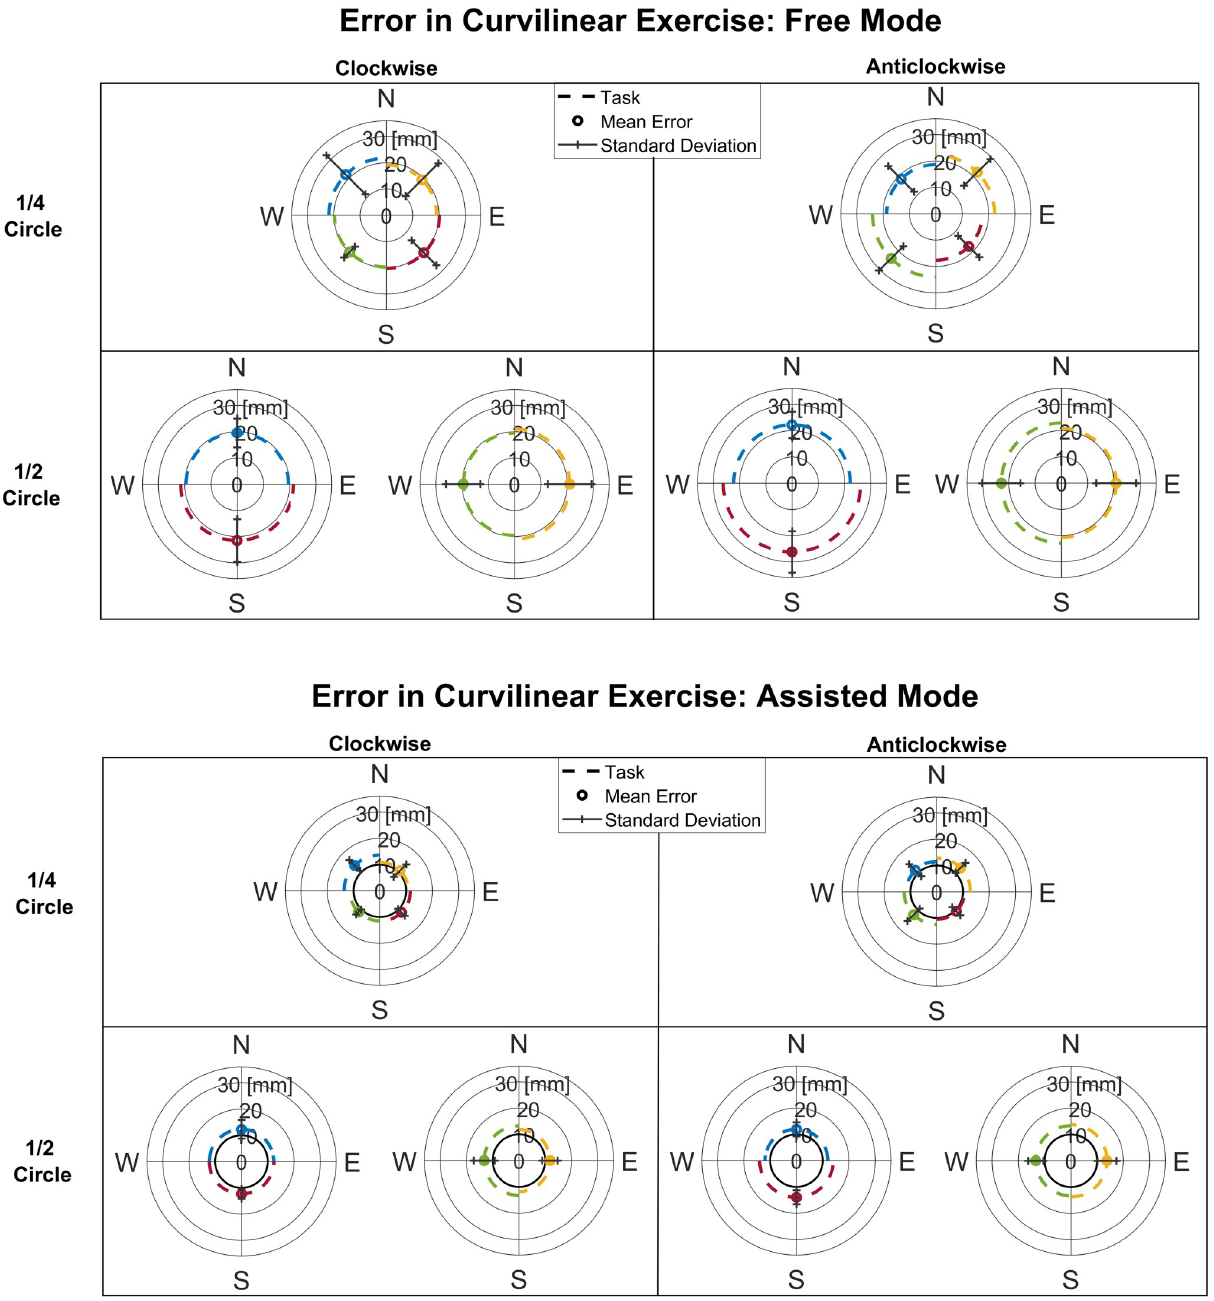
Fig 7. Curvilinear kinematic error. Mean inter-subject error and deviation in the curvilinear tasks in Free mode (upper panel) and in Assisted mode (lower panel) displayed for ¼ circle and ½ circle and for direction of execution (clockwise and anticlockwise). For the Assisted mode, the radius of the assistance tunnel is displayed in